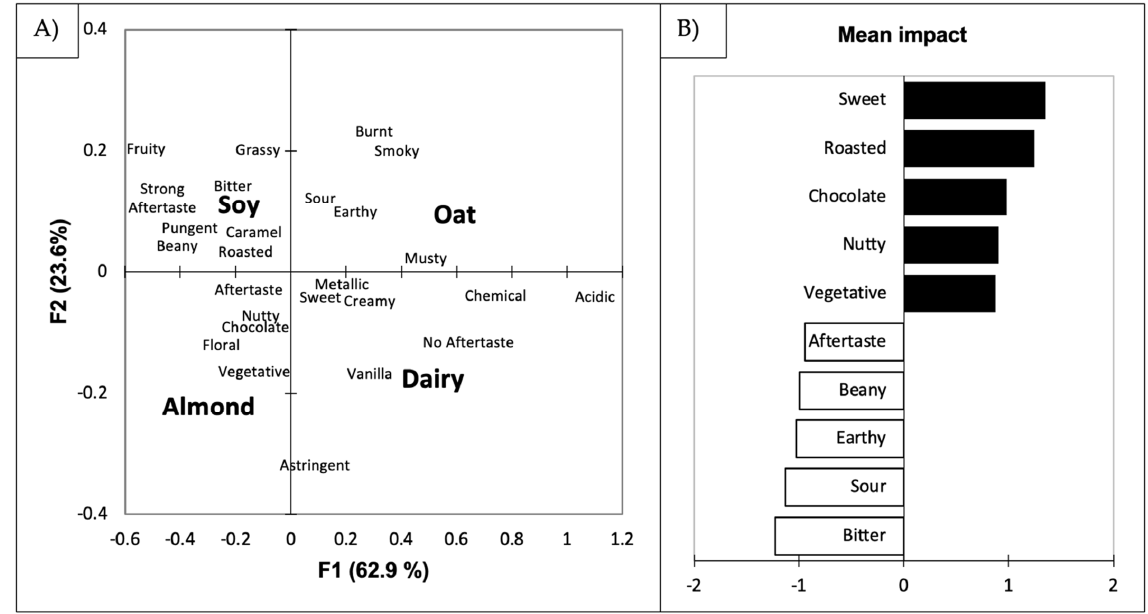
Figure 3. ( A ) Biplot representation of the sensory properties and the different coffee samples on the first two dimensions of the correspondence analysis for the plant consumers. ( B ) Penalty analysis based on the responses to the CATA question and the plant consumers’ overall liking scores.